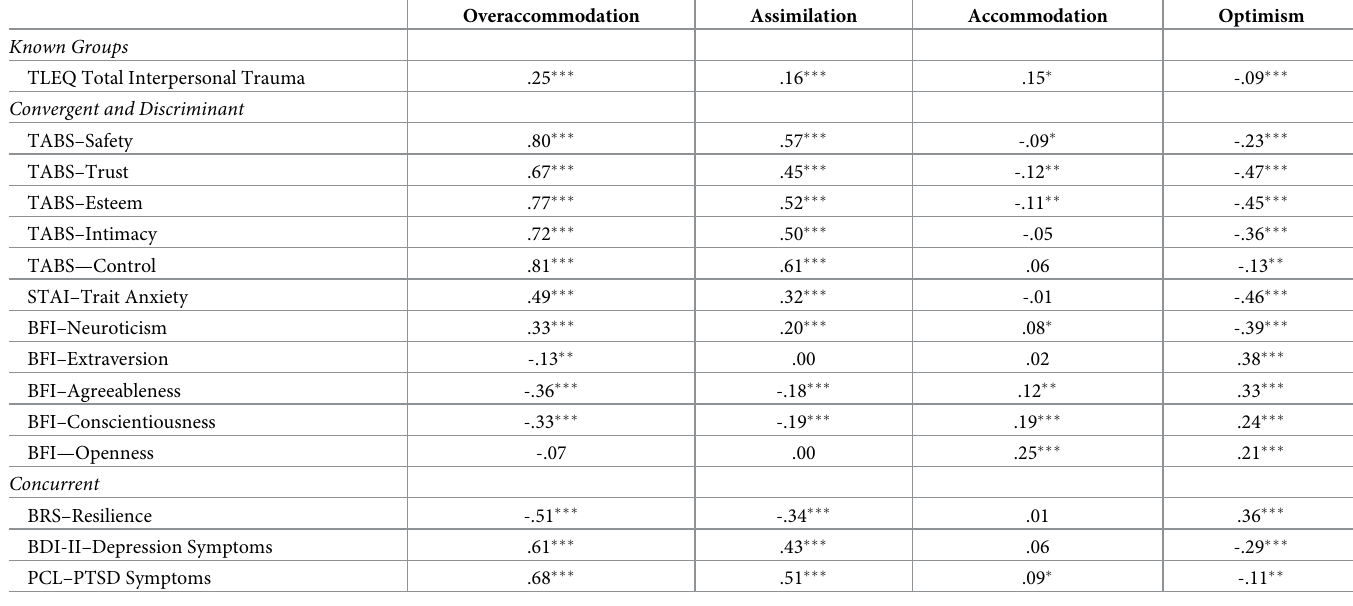
Table 4. Evidence of criterion-related validity: Phase 3 sample (N =